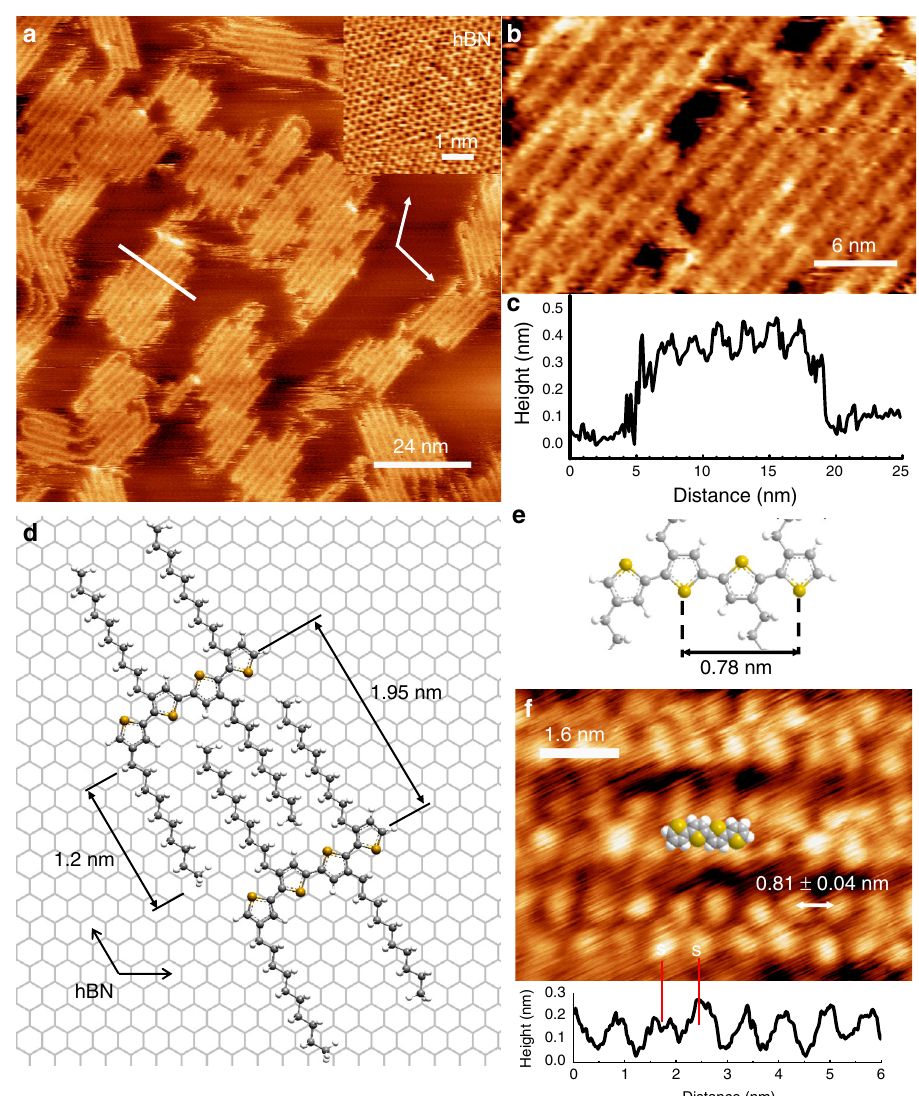
Fig. 1 High-resolution AFM images of P3DT adsorbed on the surface of hBN. a An overview height scan of P3DT assembled on hBN, scan rate 6.51 Hz, 1024 × 1024 px; inset shows lattice frequency shift image of hBN acquired in FM-AFM tapping mode, scan rate 39 Hz, 512 × 512 px; both images were acquired with the same Arrow UHF probe oscillating at fundamental frequency of 1.42 MHz. b A selected area from scan a showing individual PT molecules and low-contrast features associated with decyl side chains. c Pro fi le along the line highlighted in a showing molecule-to-molecule separation of 1.95 nm. d , e Structural models for P3DT assembly on hBN with corresponding dimensions calculated using the AM1 semi-empirical method. f Ultra-high-resolution AFM height scan of three individual P3DT molecules. Image ( f ) was acquired using third eigenmode of Multi75Al-G probe oscillating at 1.255 MHz and a setpoint of 24 mV. Scan rate 19.5 Hz, 1024 × 1024